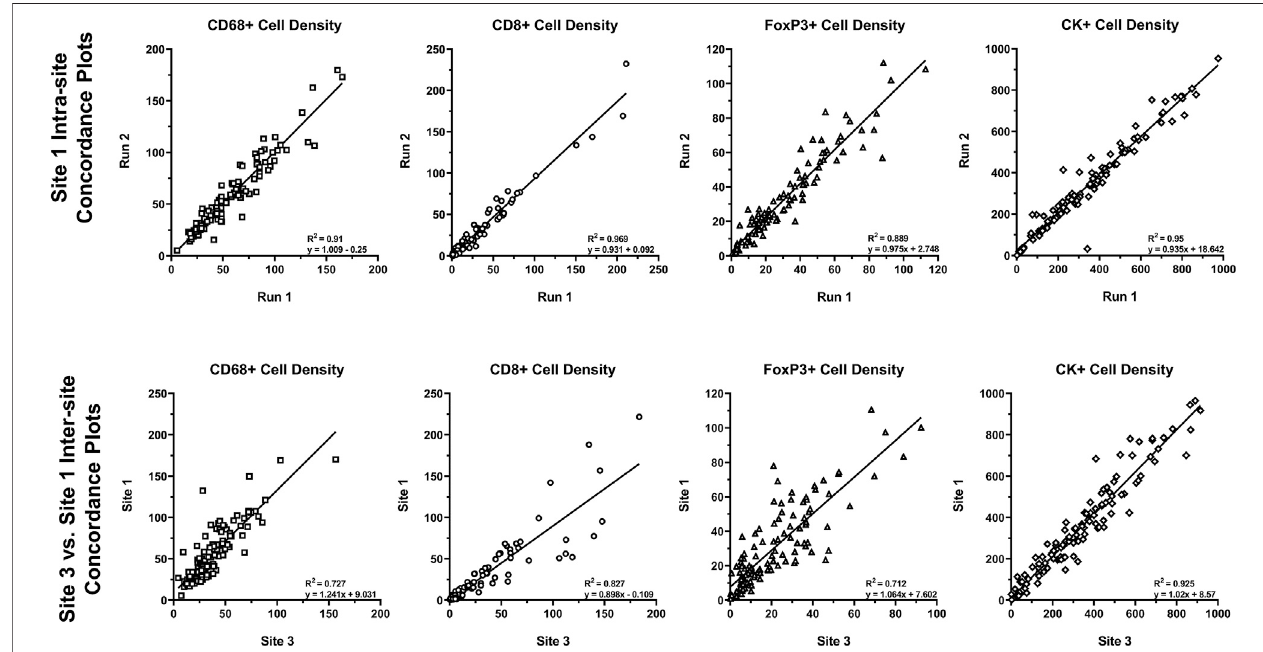
FIGURE 8 | Intra- and inter-site concordance assessment of cell densities. Average intra- and inter-site concordance plots comparing Run 1 vs. Run 2 (intra-site) and Site 1 vs. Site 3 (inter-site) cell densities for CD68 + , CD8 + , FoxP3+, and CK+. Data shown as R 2 (slope and standard deviation (SD) of slope). Graphs depict data presented as part of a study investigating multiplex IF reproducibility across multiple institutions (Hoyt et al., 2019).